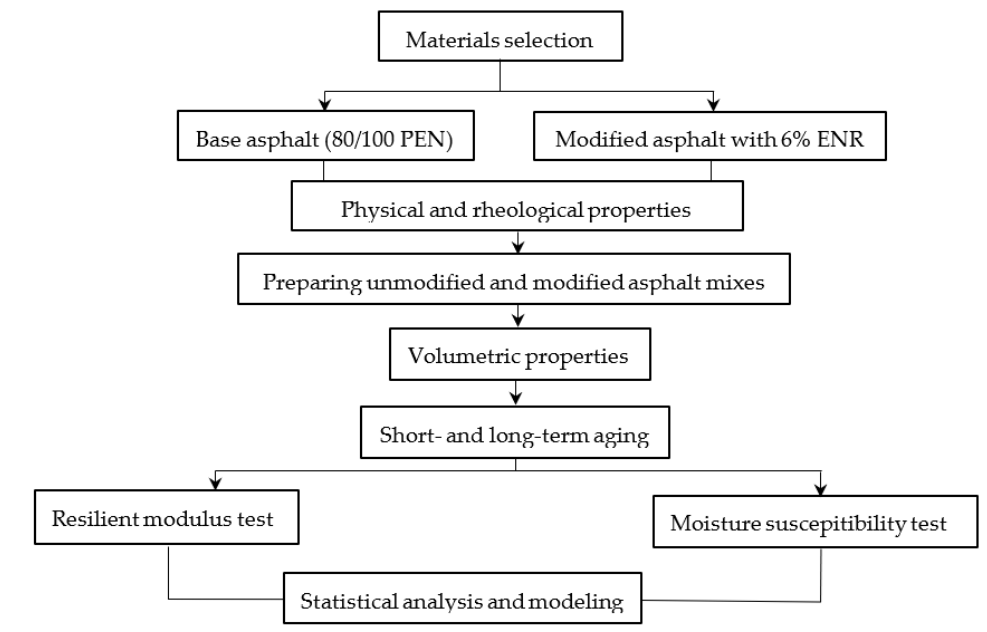
Figure 2. Flow chart of the